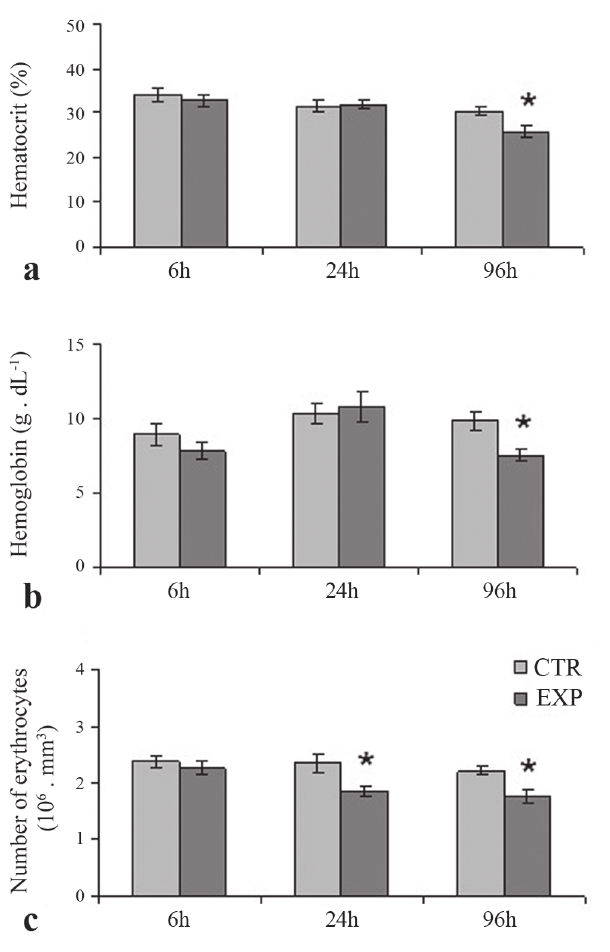
Fig. 2. Plasma concentrations of glucose ( a ), proteins ( b ) and cortisol ( c ) in Prochilodus lineatus exposed to WSFG (EXP) or only to water (CTR) for 6, 24 and 96h. Data are means ± SEM (n = 10-13), asterisks indicate different from respective control (P <